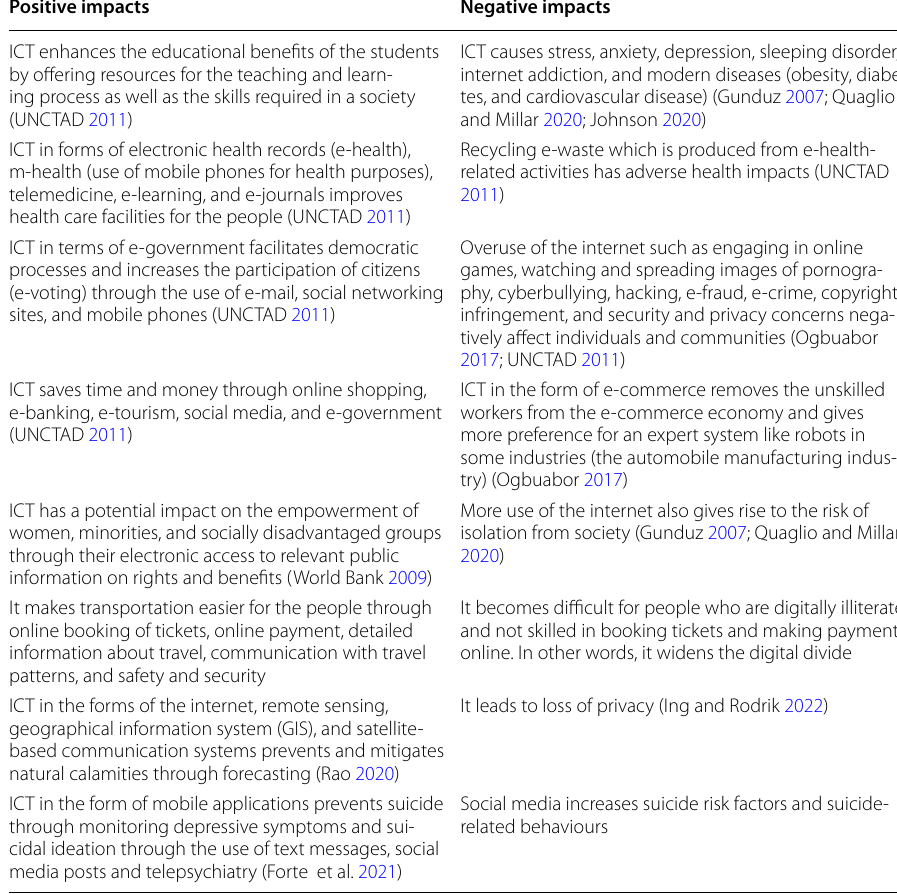
Table 12 Summary table on positive and negative societal impacts of ICT penetration Positive impacts Negative